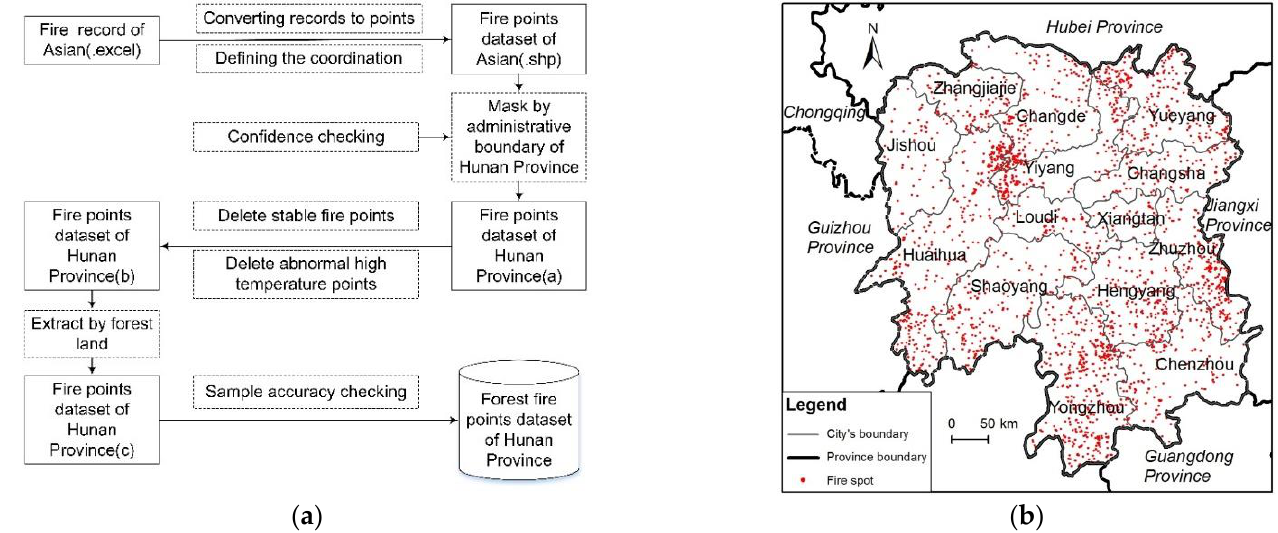
Figure 3. Wildfire in Hunan Province: ( a ) the building framework of a wildfire location dataset and ( b ) a spatial distribution map of wildfire locations during 2014 to 2020.